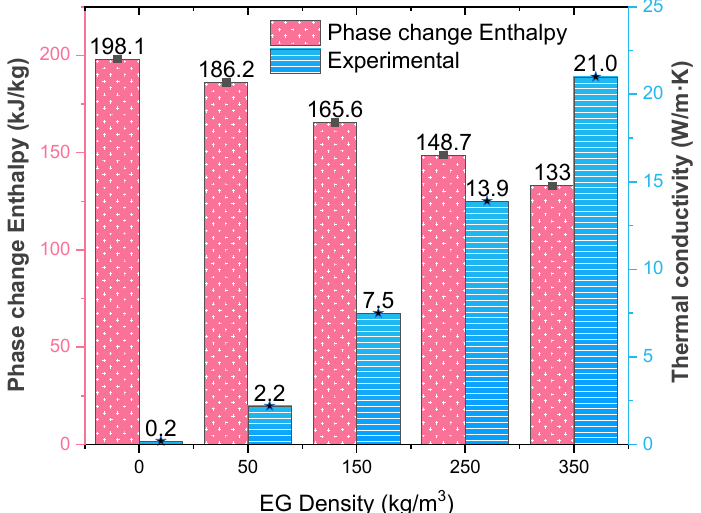
Figure 6. Variation of phase change enthalpy and thermal conductivity of n-tetradecane/EG with the EG density. Table 1. Phase change enthalpy of the n-tetradecane/EG with different EG density. Mass Per- EG Density (Kg/m 3 )